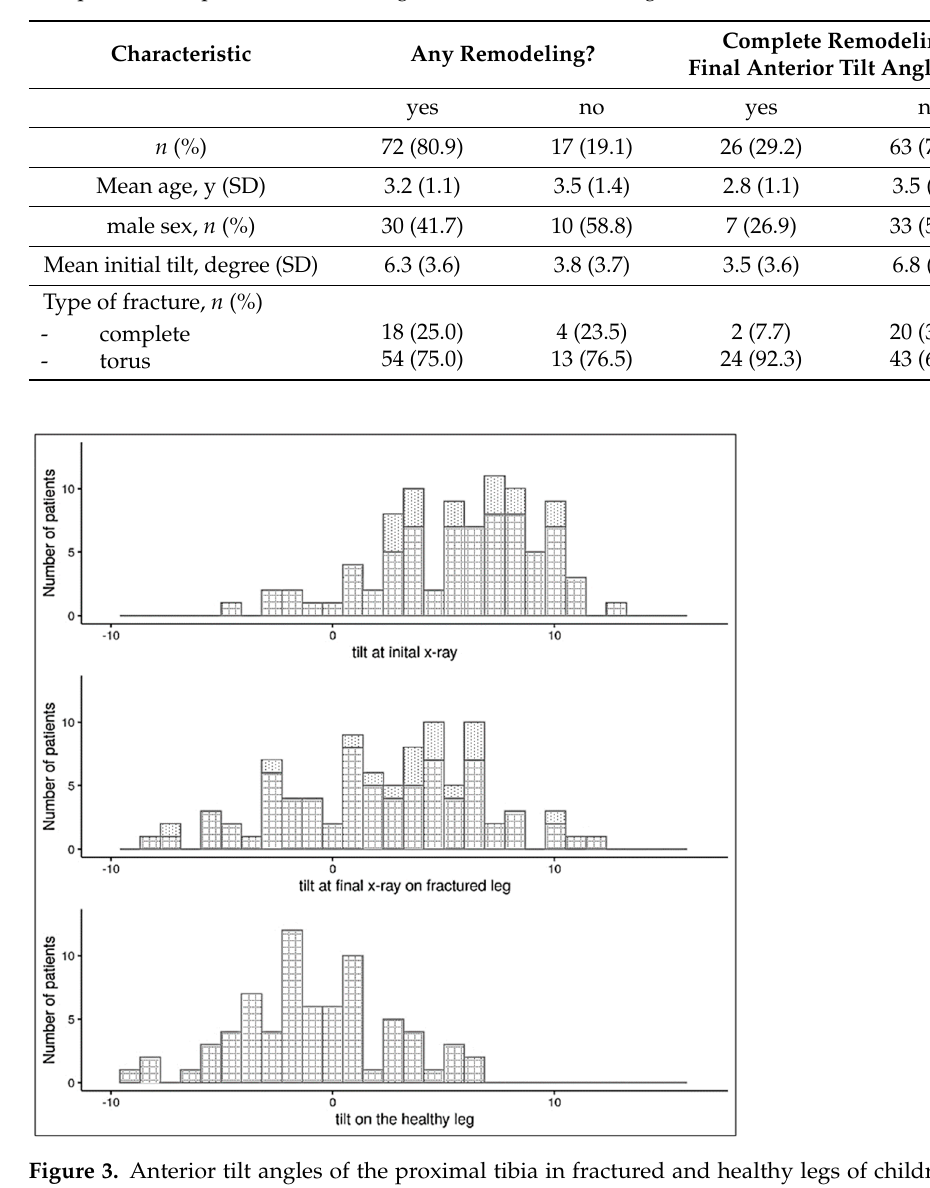
Table 2. Characteristics of children with trampoline fractures of the tibia, defined by remodeling (complete/incomplete/no remodeling) and the anterior tilt angle value at the final examination.